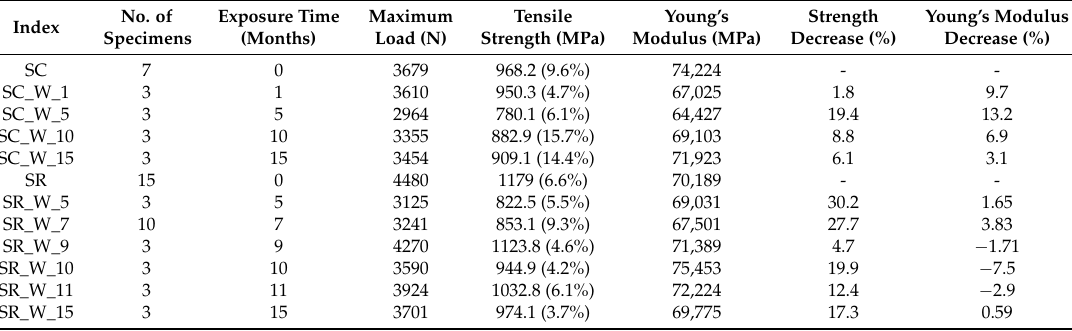
Table 6. Test results for GFRP specimens subjected to ageing treatment (distilled